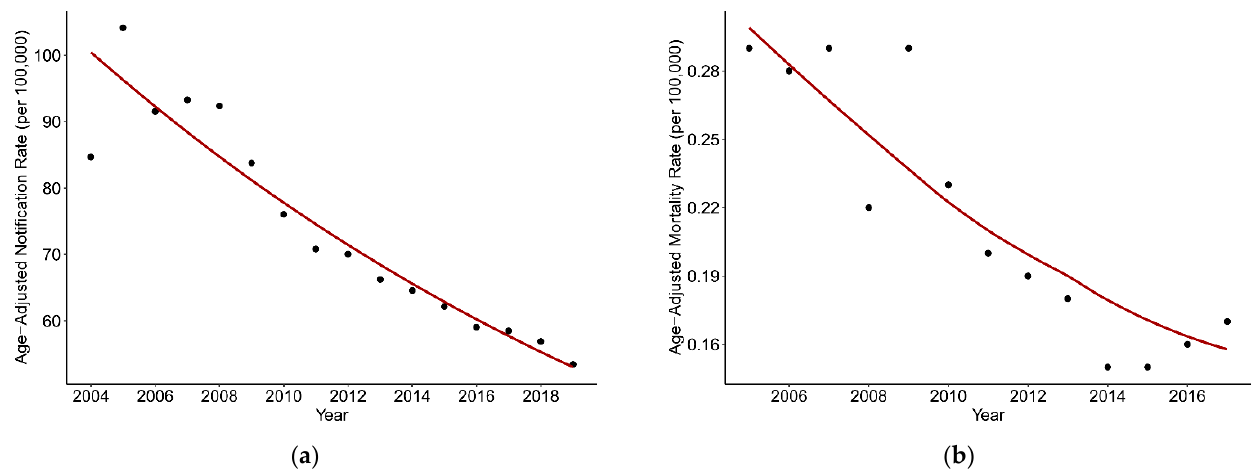
Figure 1. Temporal variations in TB age-standardized rates (per 100,000) in mainland China from 2004 to 2019. ( a ) TB age-standardized notification rate. ( b ) TB age-standardized mortality rate.